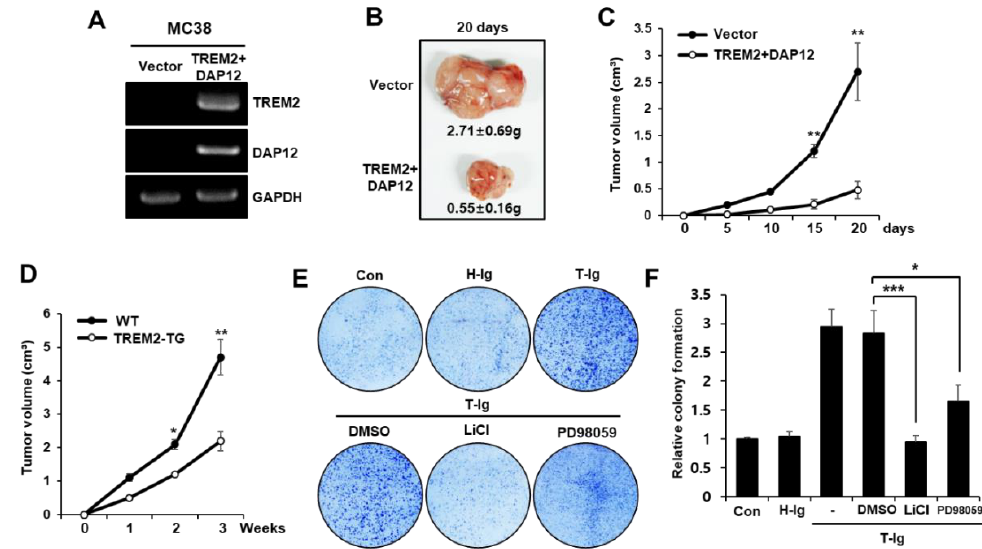
Figure 5. Inducing TREM2 expression suppresses tumorigenicity. ( A ) MC38 cells were transfected with plasmids containing the TREM2 gene or vector, ( B ) and the transfected MC38 cells (5 × 10 5 ) were injected subcutaneously into C57BL / 6J mice. Tumors were isolated from the mice after 20 days, and representative tumors are shown. ( C ) During the observation period of 20 days, the tumor volumes were measured by bilateral Vernier calipers every 5 days. ( D ) WT littermate or TREM2-TG mice were injected subcutaneously with 5 × 10 5 MC38 cells. The tumor volumes were measured and are represented in graphs. ( E ) Colony forming assays were performed in HT29 cells treated with H-Ig or T-Ig (2 µ g / mL) or LiCl (1 µ M) or PD98509 (10 µ M) for 24 h. ( F ) The colony formation density was measured by ImageJ, and the relative colony formation is represented as bar graphs. The data are representative of three independent experiments (** p < 0.01, *** p < 0.001).